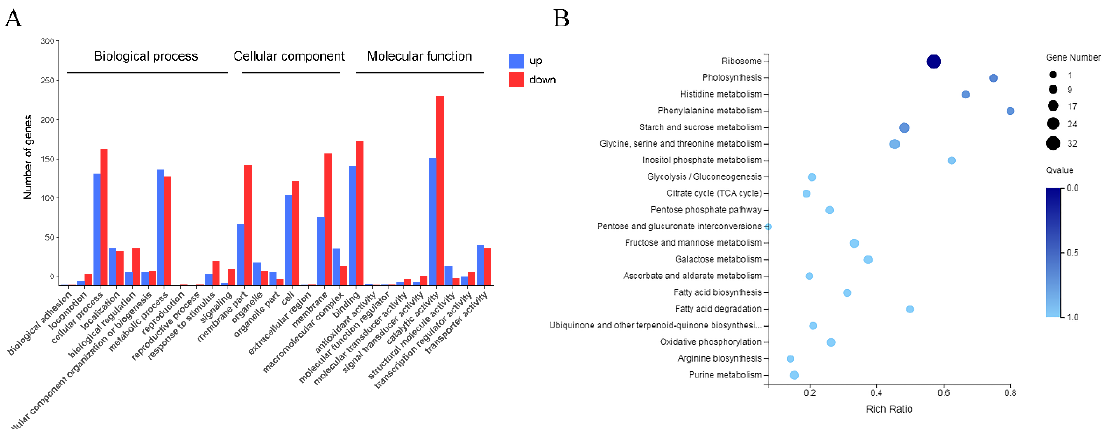
Figure 6. ( A ) Gene ontology (GO) functional annotation analysis of the differentially expressed genes (DEGs). ( B ) KEGG pathway enrichment analysis of DEGs between low-/high-salt condition. The bubble size indicates the number of genes, and the color shade represents the Q-value.